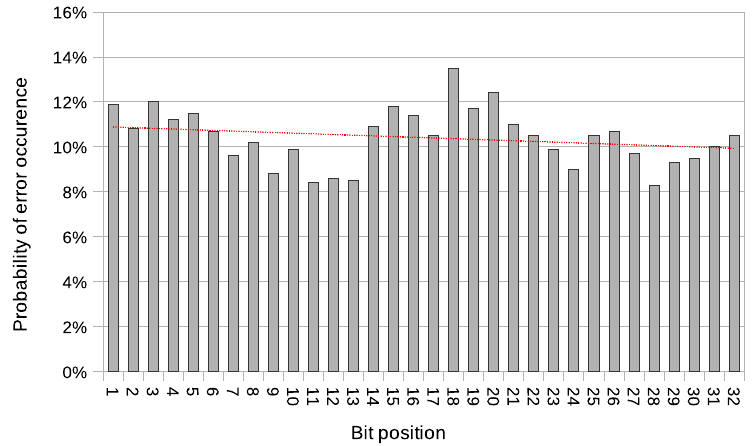
Figure 17. Probability of error occurrence as a function of bit position with a trend line (IEEE 802.11n; One-informed).